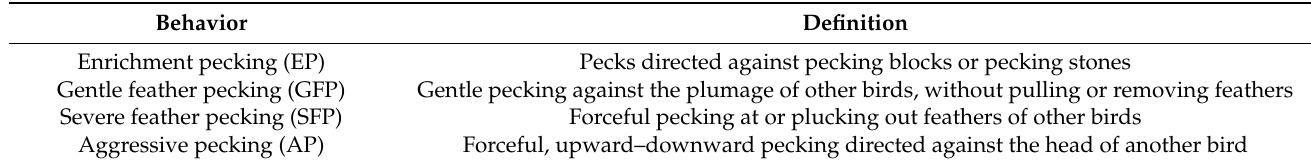
Table 2. Definitions of the pecking behavior used for video